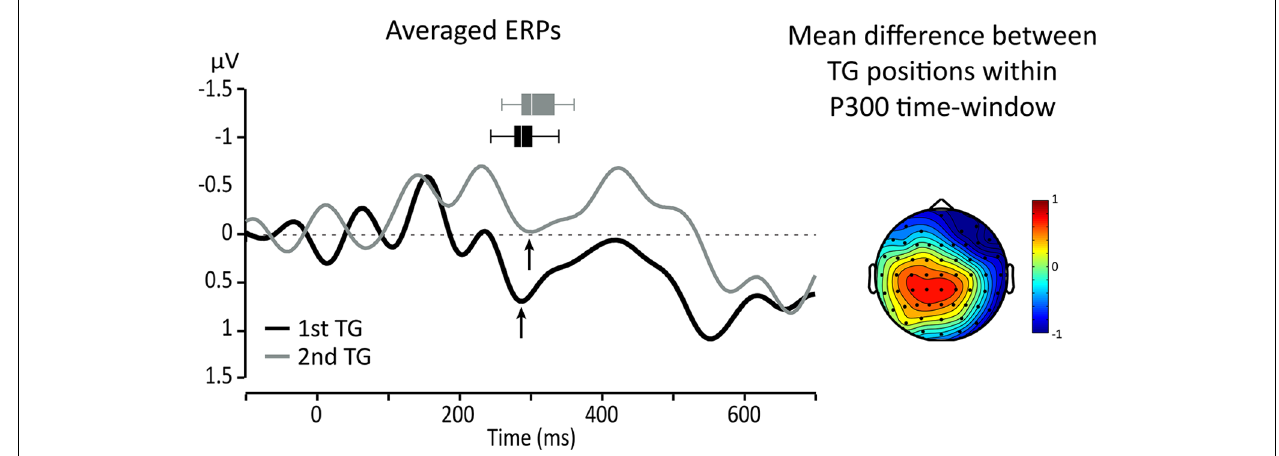
FIGURE 3 | Left: averaged responses for centro-parietal ROI: black line = first TG, gray line = second TG. Arrows indicate the peak of the P300 and horizontal box plots represent peak latency dispersion